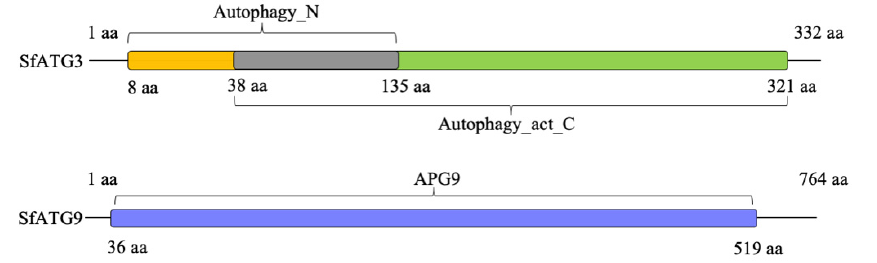
Figure 1. Prediction of the conserved domains of the deduced amino acid sequences of SfATG3 ( upper panel ) and SfATG9 ( down panel ). The autophagy_N domain and autophagy_act_C domain in SfATG3 are indicated in yellow and green boxes, respectively, and the gray box indicates sequences shared by these two domains. The APG9 domain in SfATG9 is indicated in the blue box.